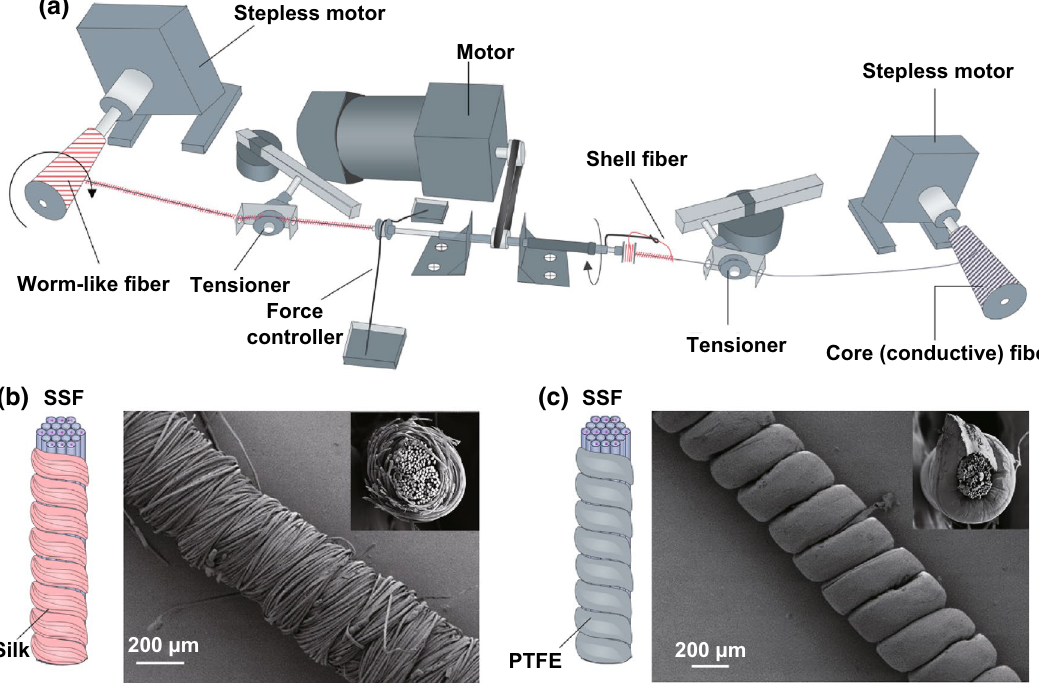
Fig. 5 Fabrication of SF/SSF and PTFEF/SSF yarns: a schematic diagram of the apparatus for fabricating SF/SSF and PTFEF/SSF yarns. Sche- matic illustration and SEM image of b SF/SSF yarns and c PTFEF/SSF yarns. The insets are SEM image of cross section of these